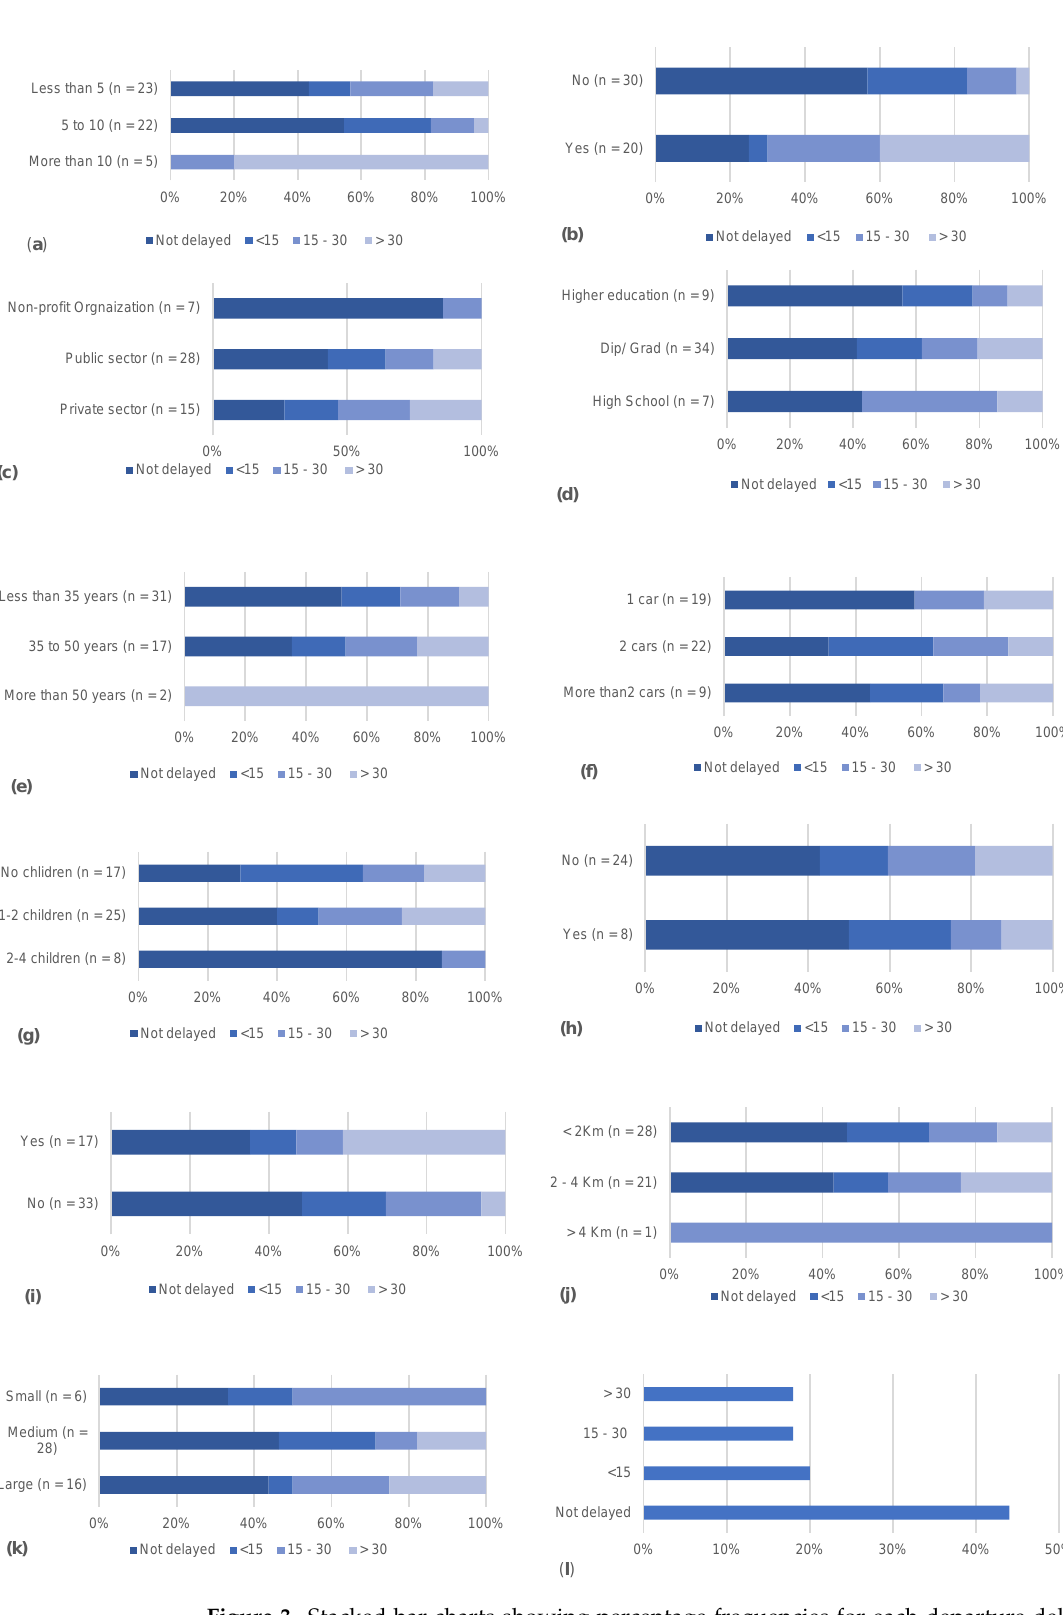
Figure 3. Stacked bar charts showing percentage frequencies for each departure delay factor for each departure delay duration: ( a ) family size, ( b ) involvement in other activities, ( c ) nature of job, ( d ) education level, ( e ) age, ( f ) number of vehicles, ( g ) number of children, ( h ) availability of driver, ( i ) availability of shopping center of choice, ( j ) distance to shopping center, and ( k ) size of the city; ( l ) percentage distribution of departure delay.